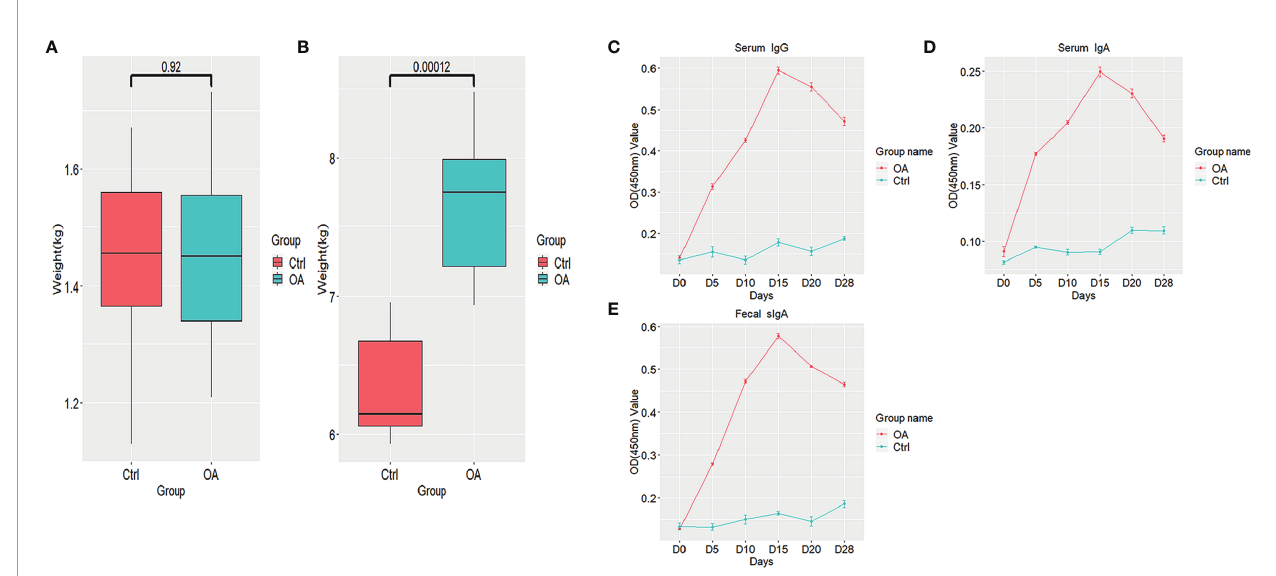
FIGURE 1 | Piglets ’ weight detail and fi mbrial K88-speci fi c antibody responses in serum and fecal samples. Piglets ’ weight detail in days 0 (A) and piglets ’ weight detail in days 28 (B) are shown by boxplots. Speci fi c IgG antibody in serum samples (C) , speci fi c IgA antibody in serum samples (D) , and speci fi c sIgA antibody in fecal samples (E) based on optical density by ELISA. All diagrams were shown by R software (version 3.6.1) with the ggplot2 package. The boxplots represent the diversity measures for the 5 analysis groups (center line, median; box limits, fi rst and third quartiles; whiskers, 1.5 × interquartile range). All outliers are plotted as individual points. The number up to the two groups means p value which is calculated by the Student ’ s